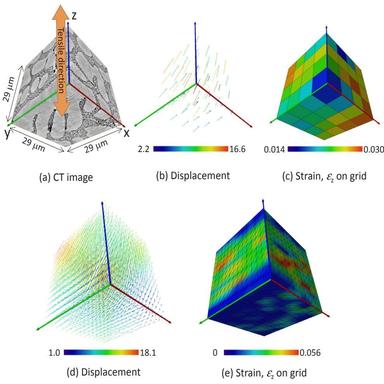
Strain analysis procedure of digital volume correlation (DVC) in Al-7mass% Mg2Si cast alloy after 5.7% tensile deformation. (a) CT image before deformation, (b) displacement and (c) tensile strain, which were obtained by the subset based (local) process with sub-volume cube size of 130 voxels as first step, then (d) displacement and (e) tensile strain, which were obtained by the Finite-Element based (global) process with sub-cell cube size of 40 voxels.